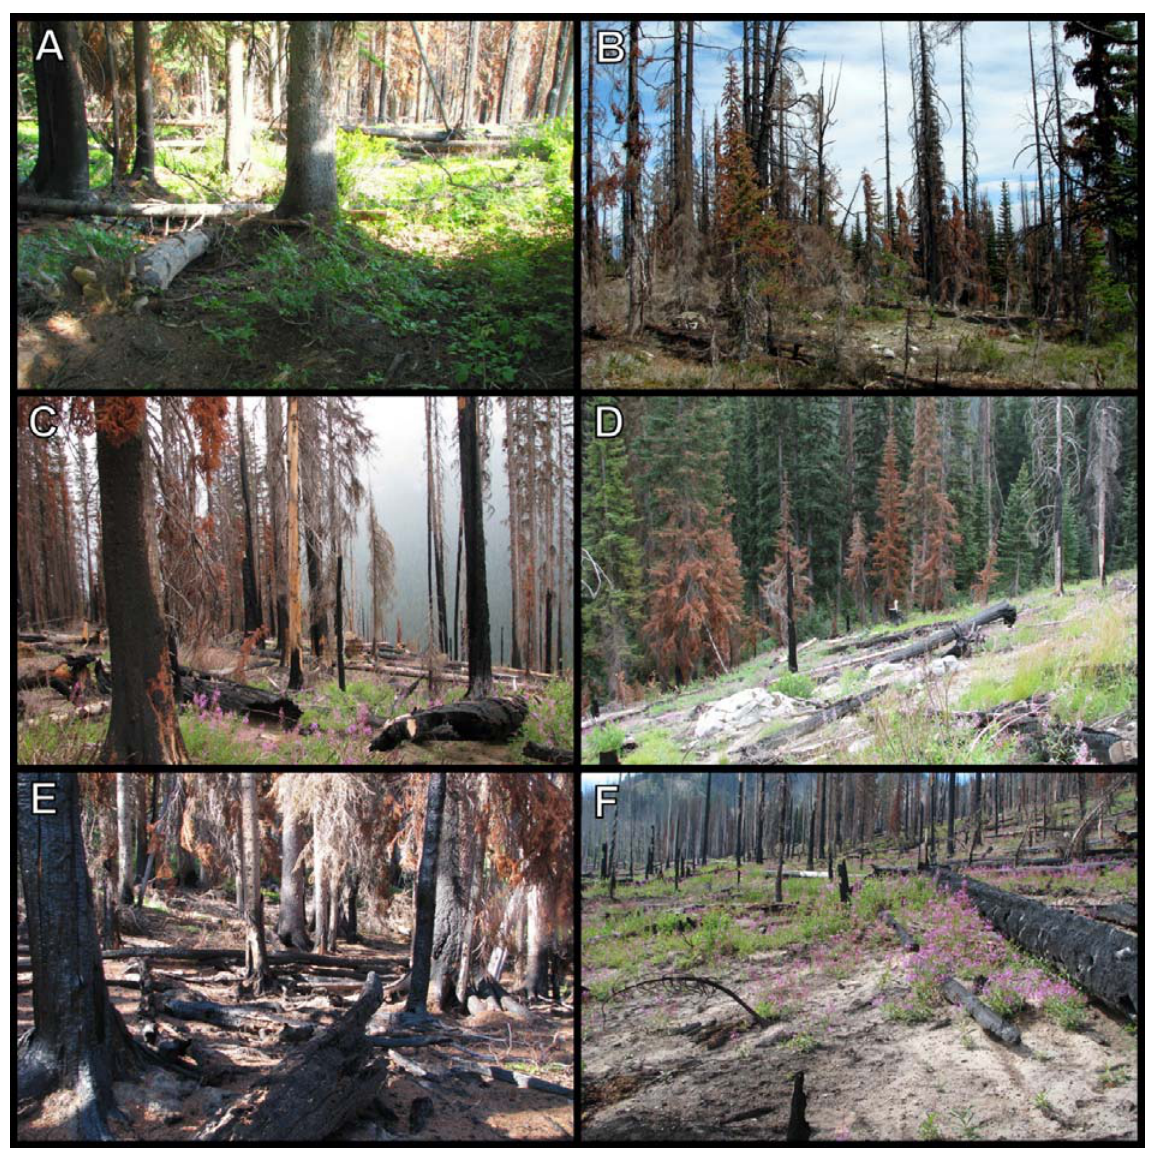
Figure 7. Examples of ( a , b ) low, ( c , d ) moderate, and ( e , f ) high severity field plots. Plots on left (a,c,e) are example of plots with little differences between CBI and WCBI. Plots on right are examples of plots where the use of WCBI notably decreased (b,d) or increased (f) the estimate of field-based burn